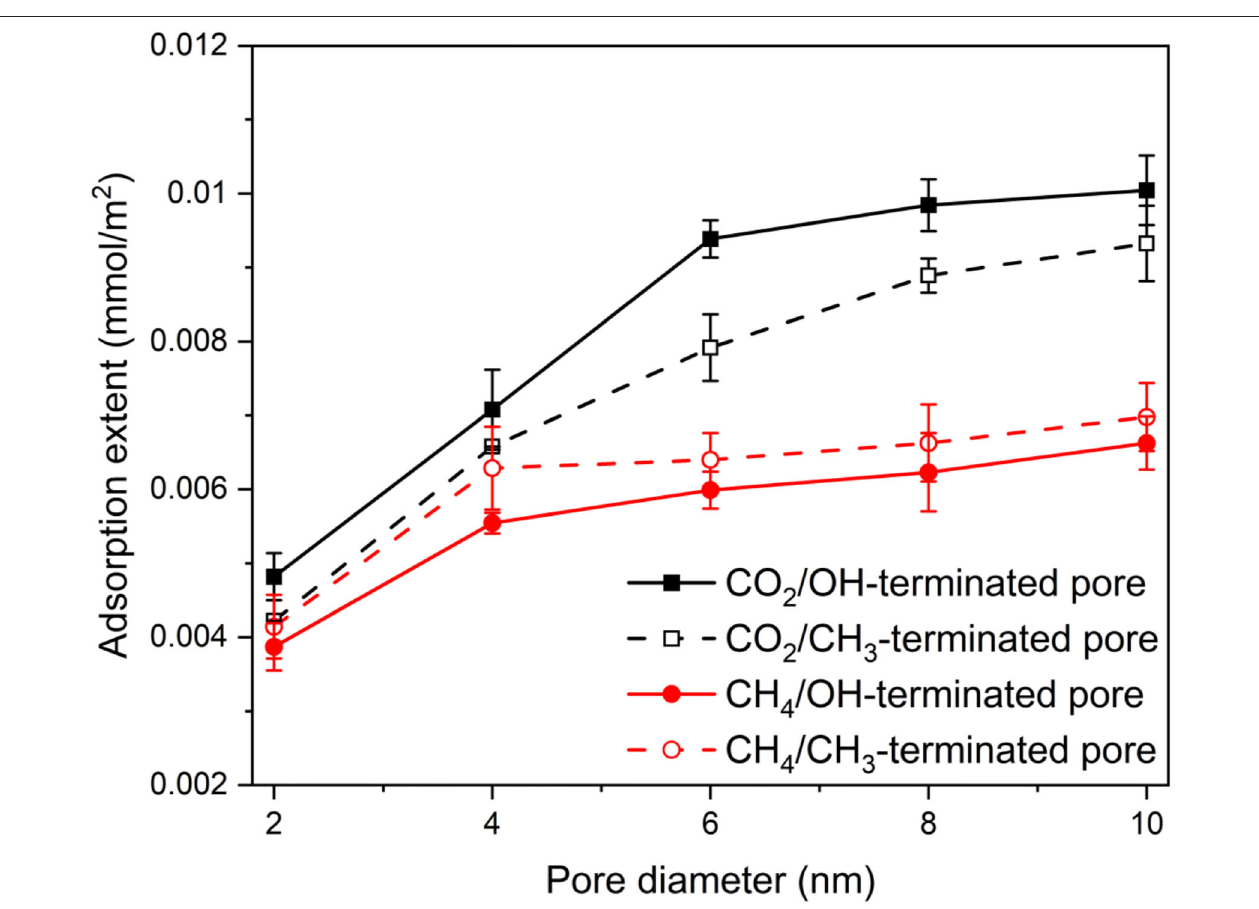
FIGURE 6 | The adsorption extents of CO 2 and CH 4 on OH-terminated and CH 3 -terminated pore surfaces as a function of the pore diameter and pore surface chemistry. The adsorption extents are determined as the number of adsorbed molecules by Avogadro number and the pore surface area. The adsorption extents are averaged over the last 10 ns of the simulation time. Error bars represent the standard deviation from the mean values of three different